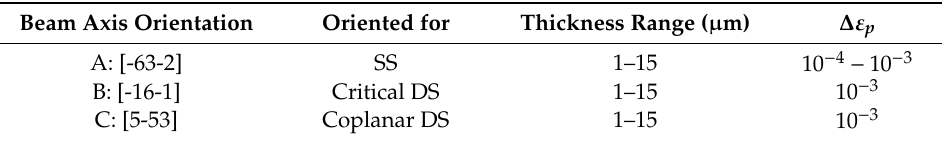
Table 1. Overview of the investigated orientations A, B, C oriented for single slip (SS), critical double slip (DS), and coplanar double slip (DS) with orientation parallel to the neutral plane, thickness range of the beams, and the plastic applied strain amplitude ∆ ε p